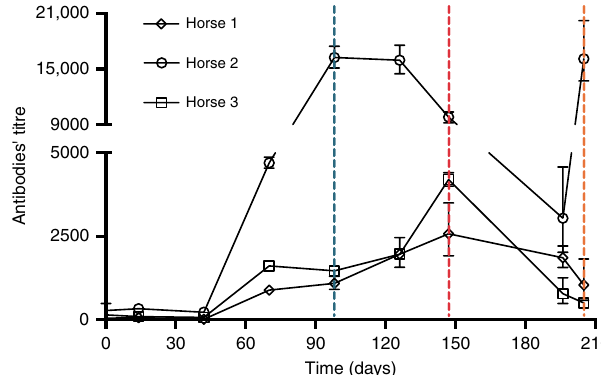
Fig. 1 Time course of the speci fi c antibody response of horses against the consensus short-chain α -neurotoxin (ScNtx). Horse hyperimmune sera raised against the ScNtx were titrated by enzyme-linked immunosorbent assay (ELISA). Dashed lines indicate samples used for neutralization tests, corresponding to days 98 (blue), 147 (red), and 205 (orange) of the immunization. Points represent mean ± SD of triplicate wells of the